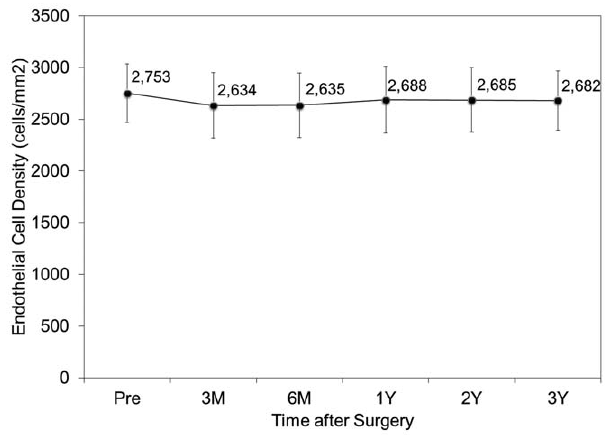
Figure 7. Time course of endothelial cell density after toric implantable collamer lens implantation. M=month, Y=year